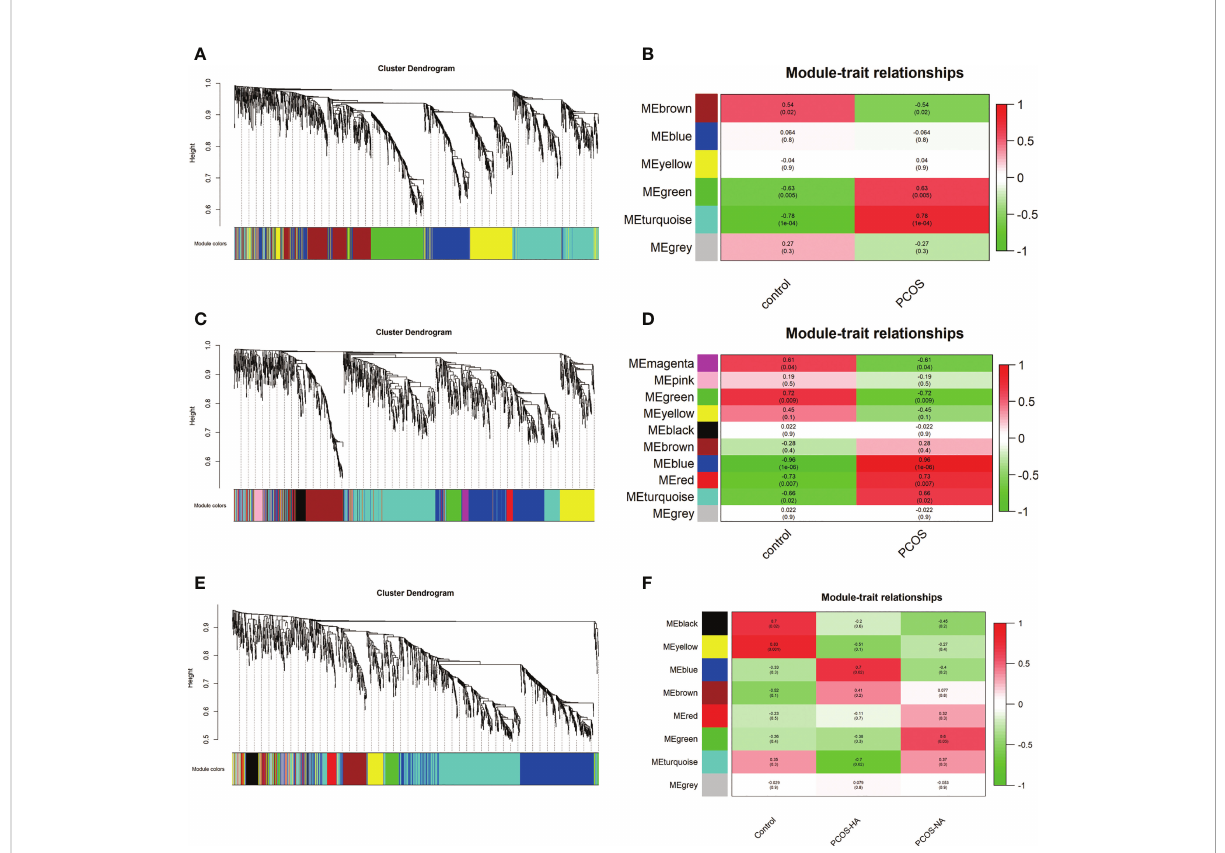
FIGURE 1 The Weighted gene co-expression network analysis (WGCNA) of key modules involved in polycystic ovary syndrome (PCOS)-associated autophagy. (A, C, E) Hierarchical cluster tree showing co-expression modules based on WGCNA in GSE8157 (A) , GSE43264 (C) ,and GSE106724 (E) . The color row underneath the dendrogram shows the module assignment determined by the Dynamic Tree Cut. (B, D, F) Correlation between key modules and clinical traits in GSE8157 (B) , GSE43264 (D) and GSE106724 (F) . Y-axis shows the modules. The fi rst row of each module is the R2 value and the closer R2 is to 1, the stronger the correlation is. The second row of each module is the p-value and p < 0.01 was considered statistically signi fi